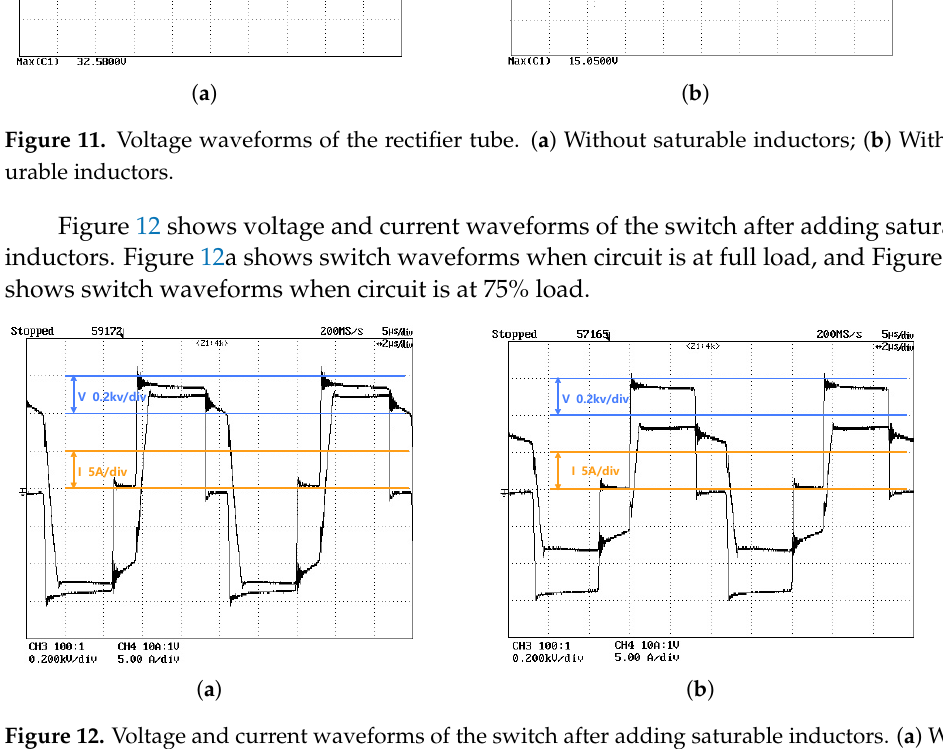
Figure 12. Voltage and current waveforms of the switch after adding saturable inductors. ( a ) Wave- forms at full load; ( b ) Waveforms at 75%